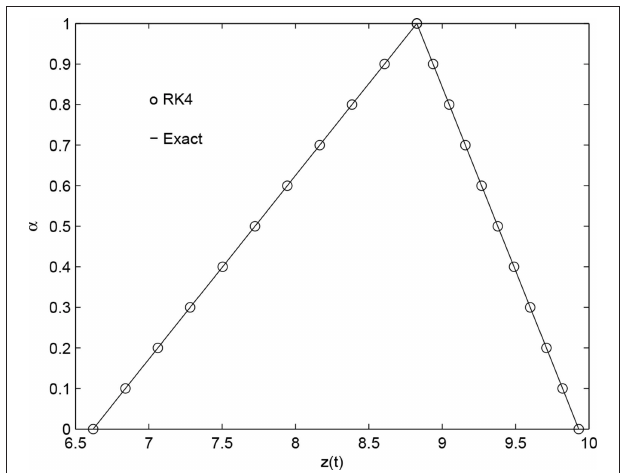
FIGURE 2 | Comparing the approximate solution with the exact solution (for h = 0.1, α ∈ [0,1] at t = 3).